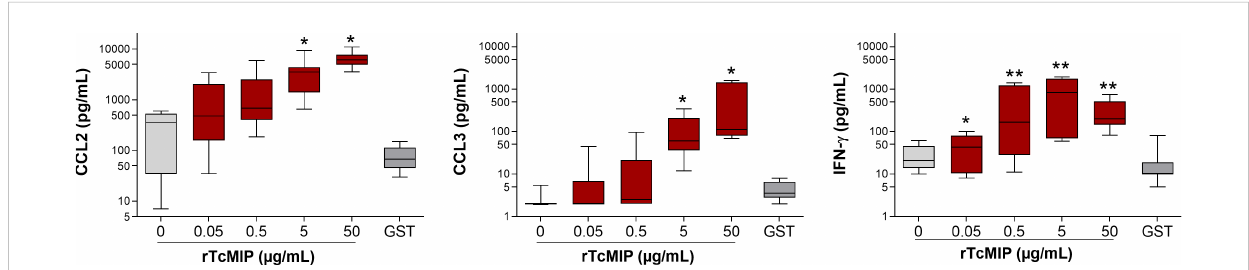
FIGURE 5 Production of CCL2, CCL3 and IFN- g by cord blood cells in response to rTcMIP. Whole cord blood (ten-fold diluted) was incubated with increasing concentrations of rTcMIP during 24h (for CCL2 and CCL3 responses) or 72h in the presence of IL-2 (5 U/mL) and IL-18 (10 ng/mL) (for IFN- g response). CCL2, CCL3 and IFN- g were measured by ELISA in the supernatants. GST: control of the rTcMIP, used at 25 µg/mL. Results are expressed as mean ± SEM (n = 12). *P<0.05, **P<0.005, rTcMIP vs. GST (Wilcoxon